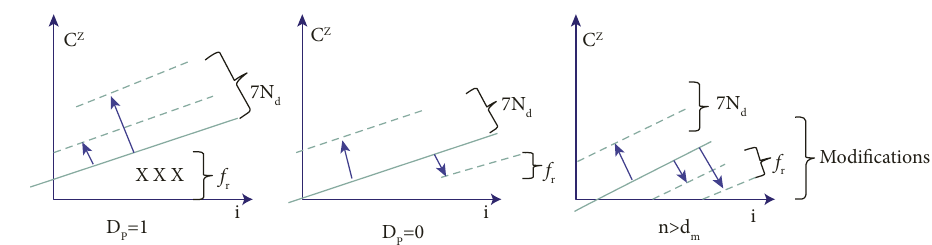
Figure 4: Modification classification of Nd from different D